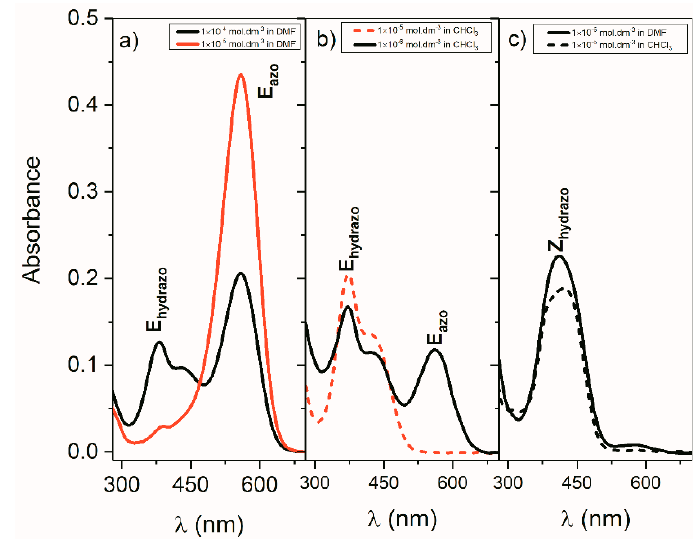
Figure 3. UV-Vis spectrum of hydrazone 3 at various concentrations: ( a ) 3 E in DMF, ( b ) 3 E in CHCl 3 , ( c ) 3 Z in DMF and CHCl 3 .